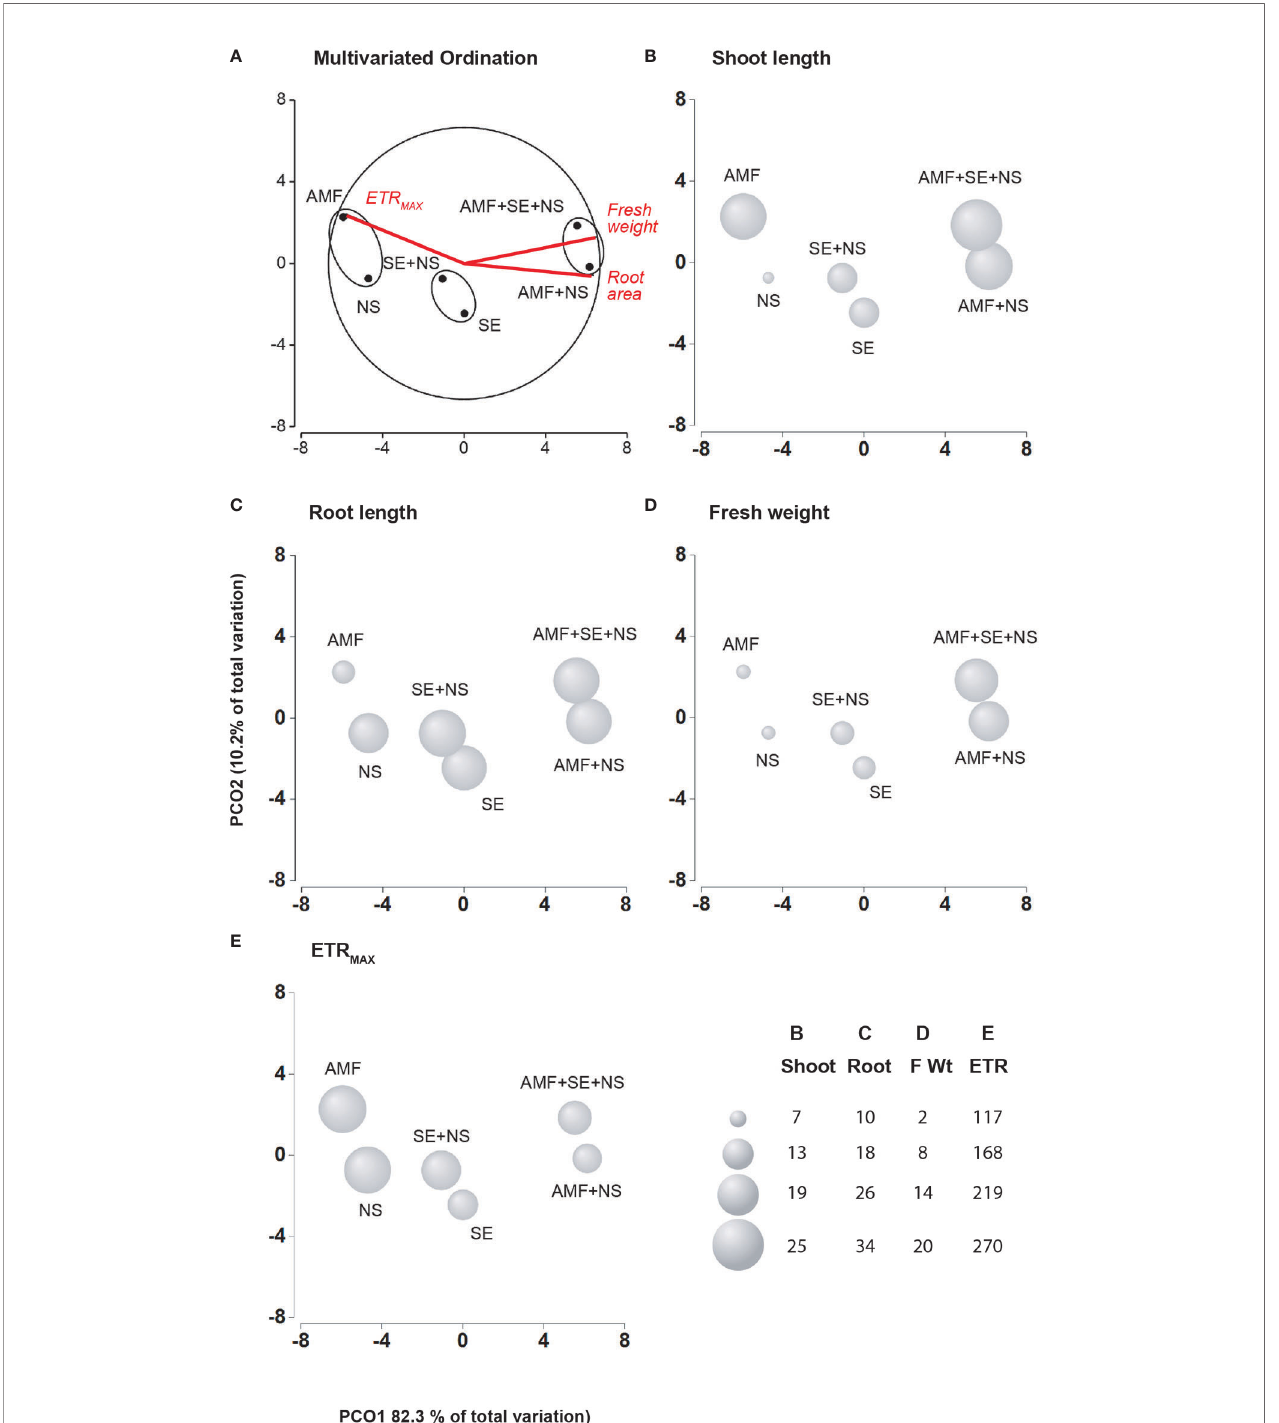
FIGURE 2 | Principal coordinates analysis (PCoA) of the physiological characteristics of the tomato plants irrigated with nutritive solution (NS), treated with a microbial-based biostimulant containing Rhizophagus intraradices [arbuscular mycorrhizal fungi (AMF)], treated with an AMF and irrigated with the nutritive solution (AMF + NS), treated with not microbial-based biostimulant from Padina gymnospora extract [seaweed extract (SE)], treated with SE and irrigated with nutritive solution (SE + NS), and a combination of both plant biostimulants and irrigated with nutritive solution (AMF + SE + NS). (A) Multivariate Ordination. (B) Shoot length . (C) Root length. (D) Fresh weight. (E) Maximum electron transport rate (ETR MAX ; n = 6